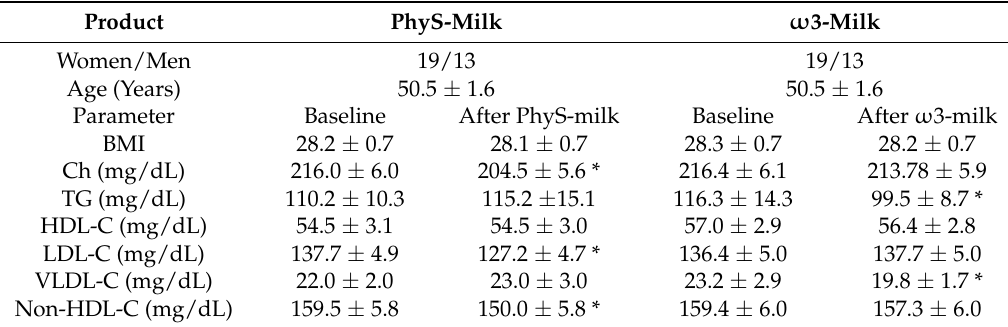
Table 1. Demographic and biochemical